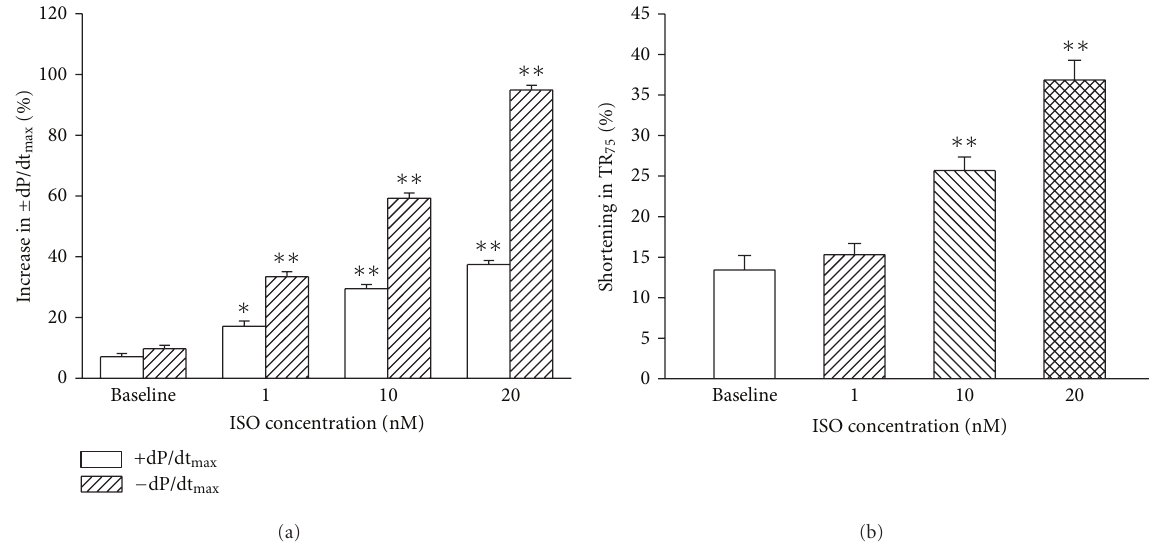
Figure 4: Percentage increases in ± dP/dt max and TR 75 under combined e ff ect of the pacing and ISO. (a) The percentage increases in ± dP/dt max between the pacing of 420 beats/min and intrinsic heart rate without and with ISO treatment. (b) The percentage shortenings in TR 75 between the pacing of 420beats/min and intrinsic heart rate without and with ISO treatment. Data are mean ± SEM, n = 6 hearts for each ISO concentration in each group. ∗ P < 0 . 05 or ∗∗ P < 0 . 01 versus